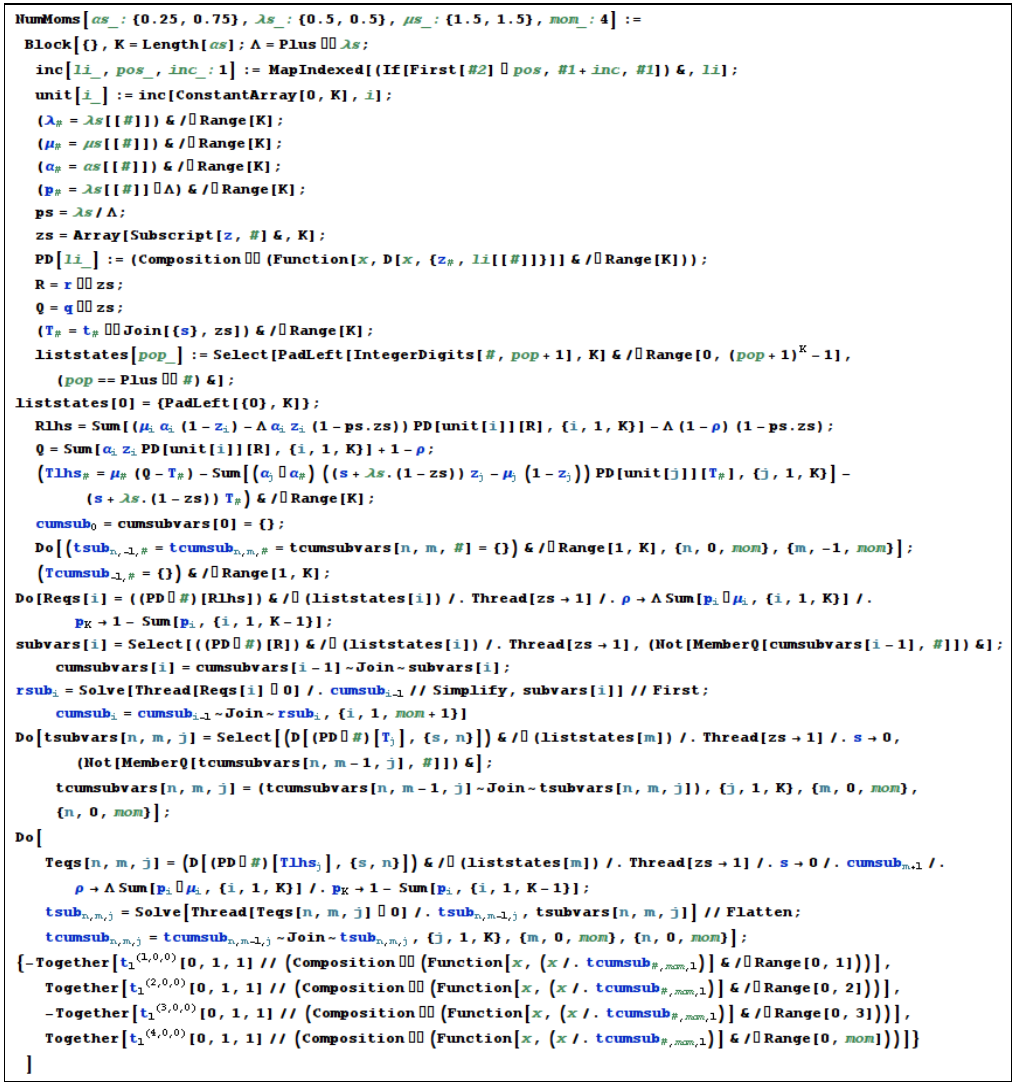
Figure 1: Mathematica code of the automated algorithm with two job classes and four moments.